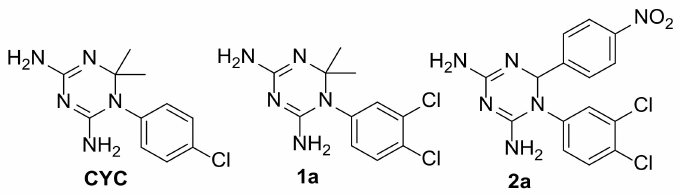
Figure 2. CYC and its analogues previously studied as Tb PTR1 inhibitors